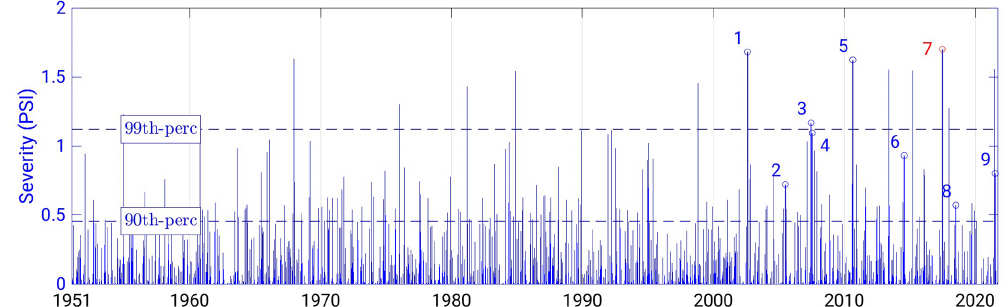
Figure 6. Temporal evolution of the PSI (blue bars) for the time period 1951 to 2021. The results are based on REGNIE daily precipitation observations between January 1951 and September 2021. The 99th percentile and 90th percentile of daily PSI values are represented by the dashed blue horizontal lines. Numbered circles highlight nine events analysed in Table 1 or in Fig. 7 and other historical events. These are (1) the Saxony floodings on the 12 August 2002; (2) the 29 June 2005 event, affecting Hersbruch and Lohmar; (3) the 21 June 2007 and the (4) 22 July 2007 events affecting Germany in its totality; (5) the 26 August 2010 event in Osnabrueck; (6) the 29 July 2014 event in Muenster and Greven; (7) the 29 June 2017 HPE (red); (8) the 12 July 2018 causing flooding in Berlin; and (9) the Ahr flooding on 14 July